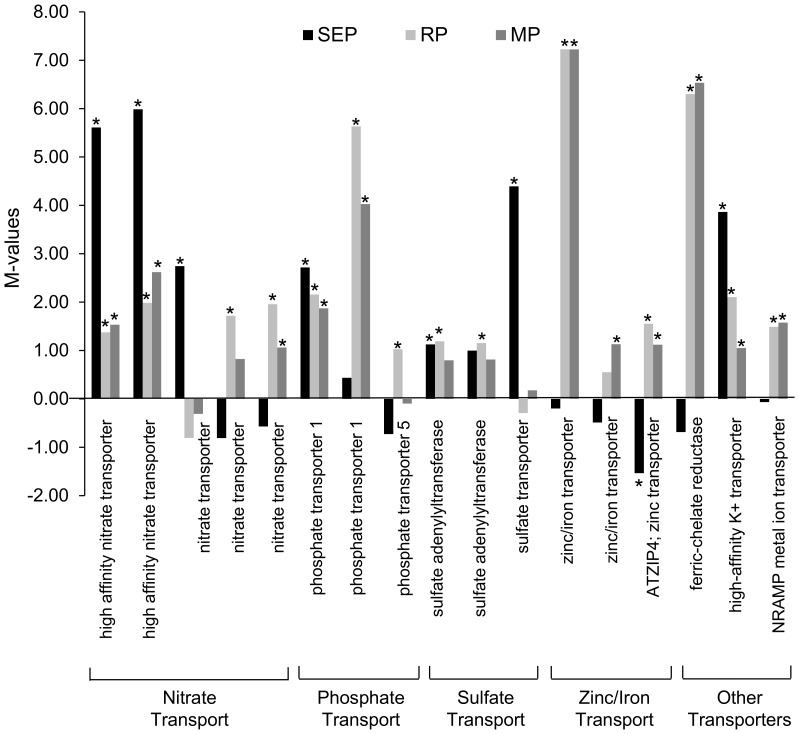
Fold change ratios of mineral nutrient transporters during AR formation in petunia cuttings.M values (Log2 of fold change ratios) of genes involved in mineral nutrient transport and processing during various phases of AR formation in petunia cuttings compared to the time point 0 hpe. SEP: Sink Establishment Phase; RP: Recovery Phase; MP: Maintenance Phase. Sequence ID for each gene in sequential order as illustrated in the figure: high affinity nitrate transporters (GO_drpoolB-CL2736 Contig1, GO_drs31P0006M14_R_ab1), nitrate transporters (cn1356, cn7095, GO_drpoolB-CL8921Contig1), phosphate transporter 1 (cn1272, cn8235), phosphate transporter 5 (cn8236), sulfate adenylyltransferases (GO_drpoolB-CL2256Contig1, GO_drpoolB-CL4792Contig1), sulfate transporter (cn6307), zinc/iron transporters (cn5371, GO_dr004P0016I22_F_ab1), ATZIP4 zinc transporter (IP_PHBS009K04u), ferric-chelate reductase (GO_drpoolB-CL1069Contig 1), high-affinity K+ transporter (cn7074), NRAMP metal ion transporter (GO_drpoolB-CL1711Contig1). Significant changes are indicated by asterisks.